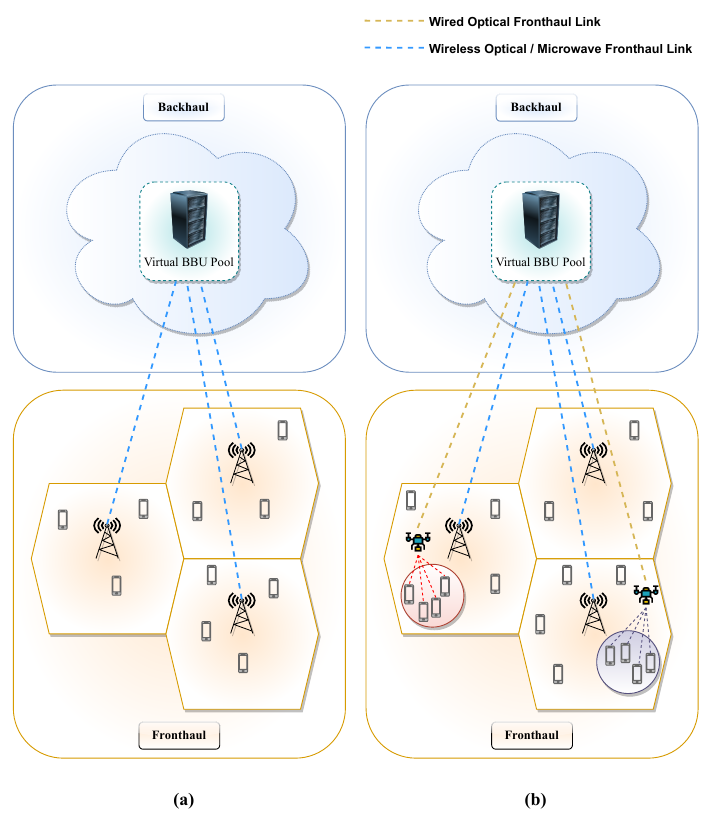
Figure 1. The configuration of the considered 5G two-tier heterogeneous cloud radio access network (H-CRAN): ( a ) Operating under normal traffic load and before the placement of UAV-BSs. ( b ) A heavily loaded scenario caused by an unexpected event and network offloading via the deployment of